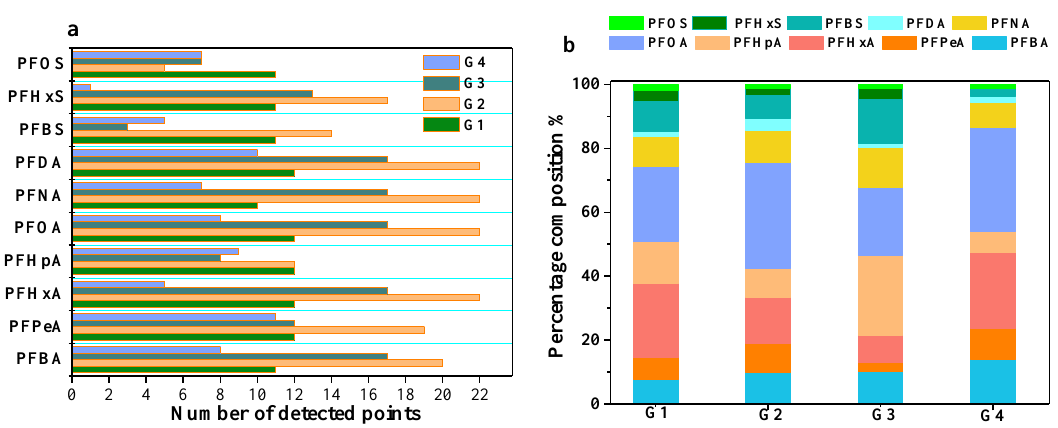
Figure 5. Number of detected points ( a ) and percentages of 10 PFAS in groundwater samples ( b ) in four regions from the APPHR in Shijiazhuang City.